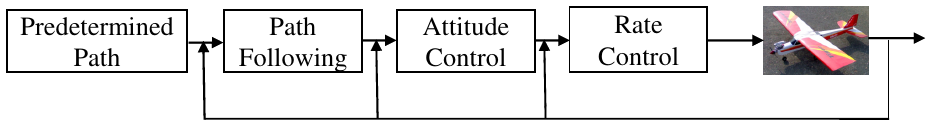
Figure 1. Nonlinear flight control